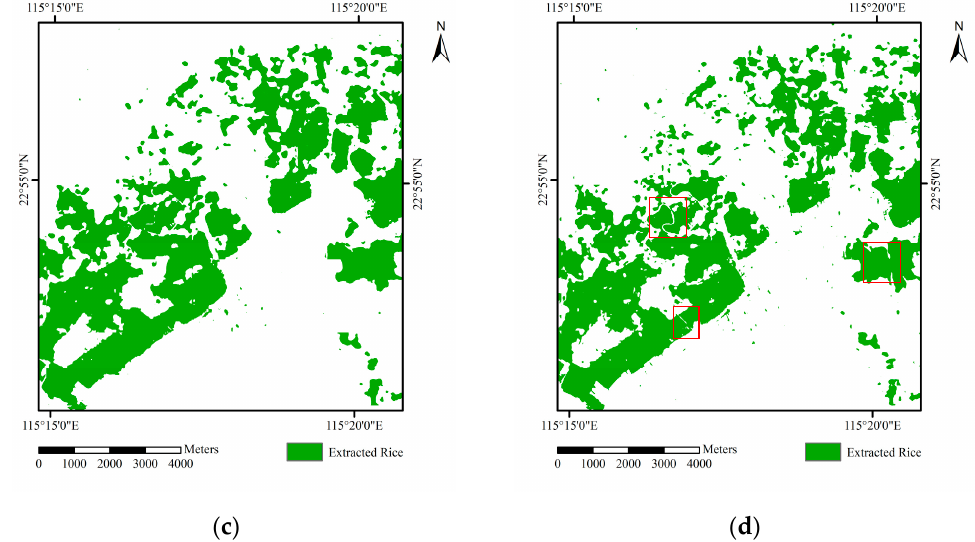
Figure 8. Comparison of rice field extraction results by different methods: ( a ) SAR; ( b ) RF; ( c ) Deeplabv3+; ( d ) SGEM.